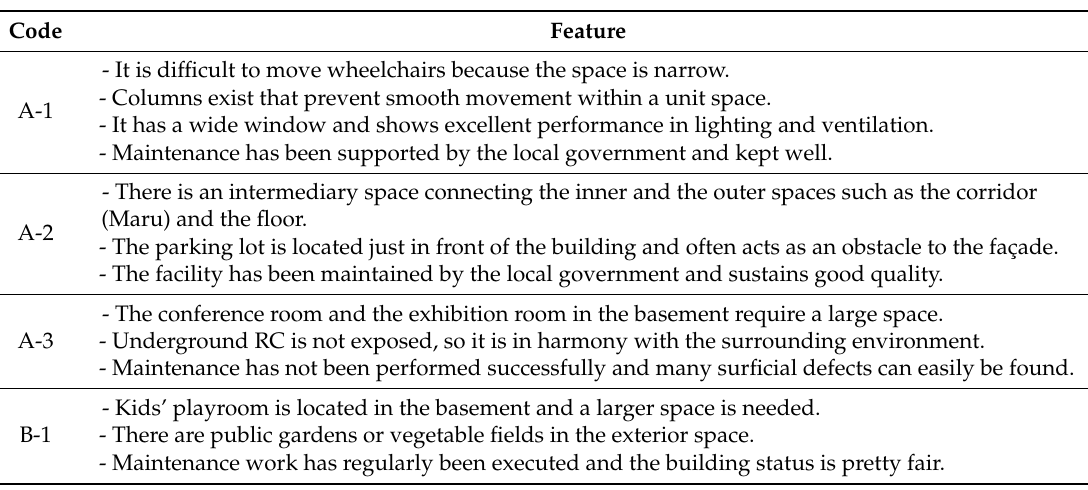
Table 6. Sample survey results in the spatial usability for target